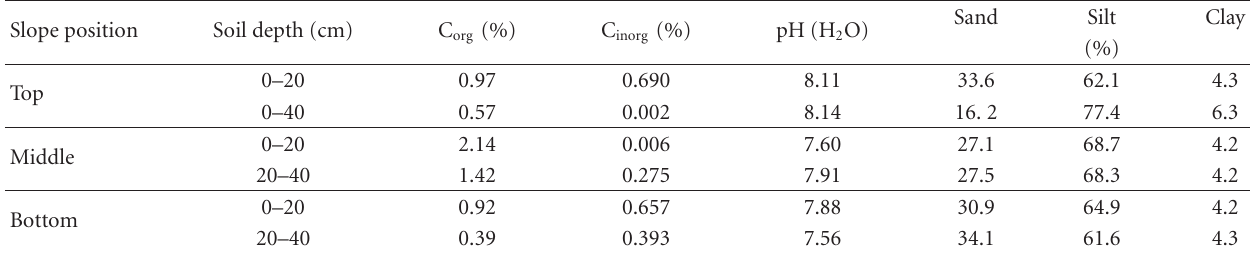
Table 1: Basic characteristics of loess soils at three slope